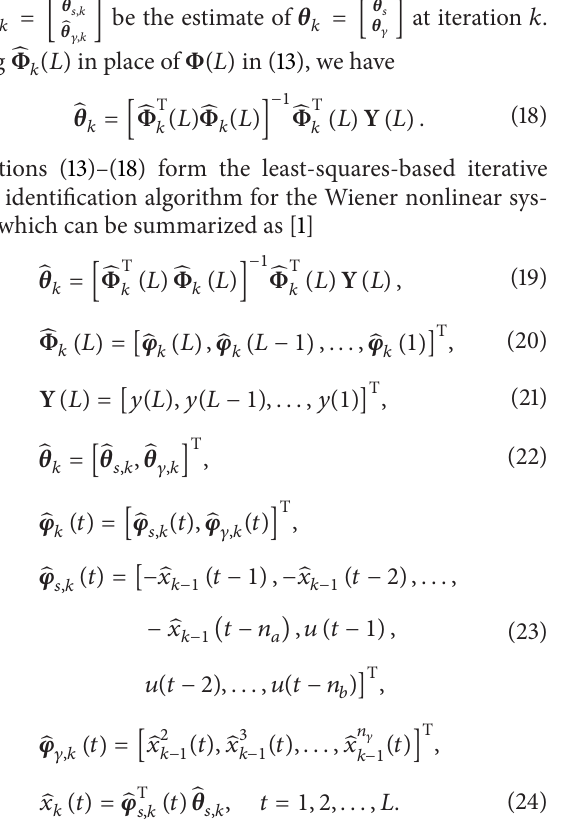
Figure 2: The flowchart of computing the LSI estimate